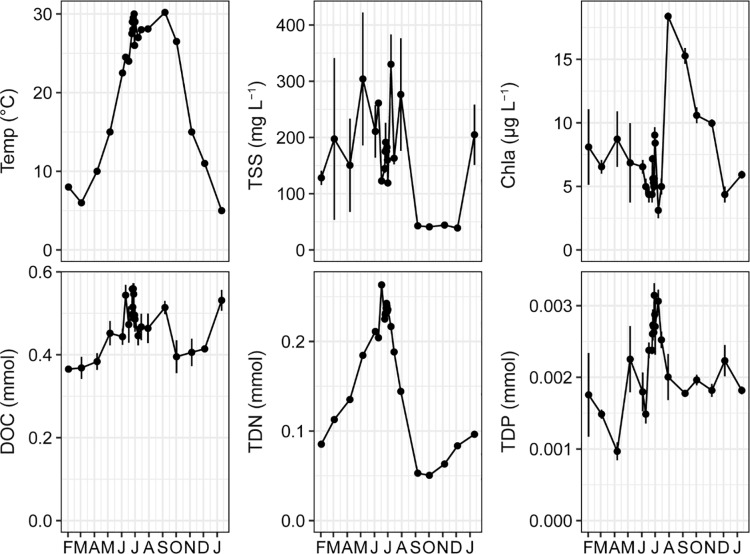
Environmental variables measured in Lower Mississippi River water between February 2013 and January 2014.Abbreviations: Temp, water temperature; TSS, total suspended solids; Chla, chlorophyll a; DOC, total dissolved organic carbon; TDN, total dissolved nitrogen; TDP, total dissolved phosphorus. Except for water temperature, parameter measurements are presented as means (± SE) for each date, n = 2–3. For clarity, sample dates are connected by lines. These lines are not intended to convey patterns of variation at shorter time intervals than what is shown.